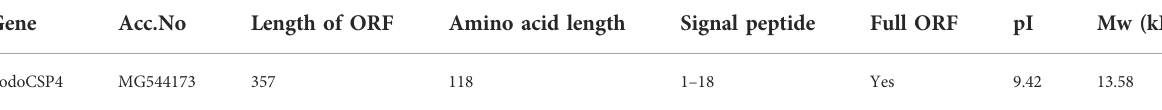
TABLE 2 Bioinformatics analysis of odorant-binding protein genes in B.odoriphaga .